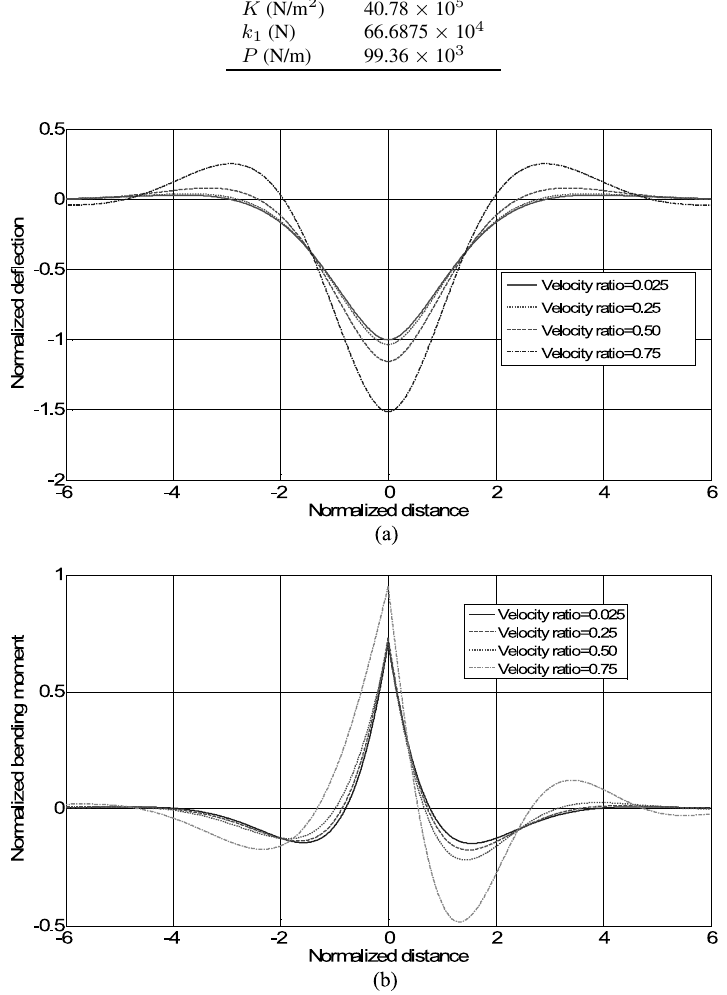
Fig. 4. Normalized (a) de fl ection and (b) bending moment responses with different velocity ratios ( c/c cr =